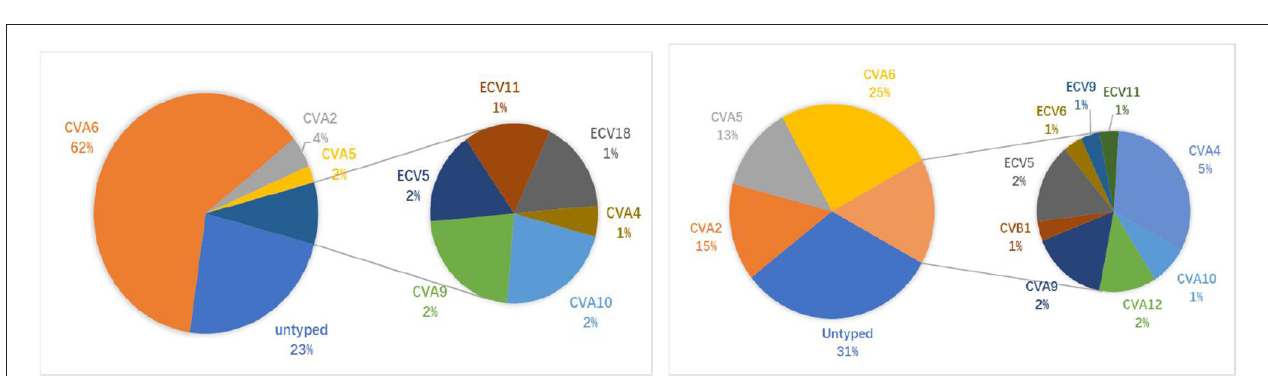
FIGURE 2 | Percentage of non-EV-A71/CVA16 serotypes in HFMD/HA patients. Left : HFMD (166 cases in total); Right : HA (107 cases in total).